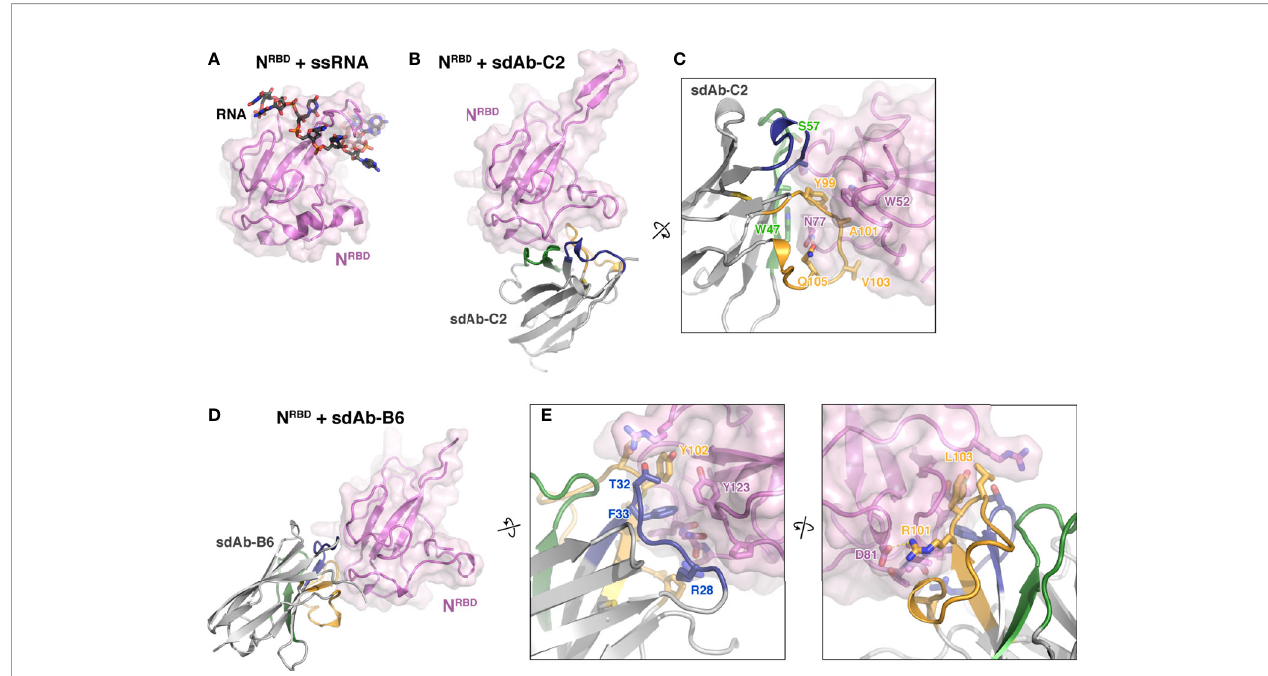
FIGURE 2 | Structures of two sdAbs targeting the SARS-CoV-2 N protein RBD. (A) Structure of the SARS-CoV-2 N RBD (pink) bound to single-stranded RNA (black) [PDB ID 7ACT (30)]. (B, D) show the N RBD in the same orientation. (B) Structure of N RBD (pink) bound to sdAb-C2. CDR1, CDR2, and CDR3 are colored blue, green, and orange as in Figure 1C . (C) Close-up view of the N RBD :sdAb-C2 complex. (D) Structure of N RBD (pink) bound to sdAb-B6. CDR1, CDR2, and CDR3 are colored blue, green, and orange as in Figure 1C . (E) Two close-up views of the N RBD :sdAb-B6